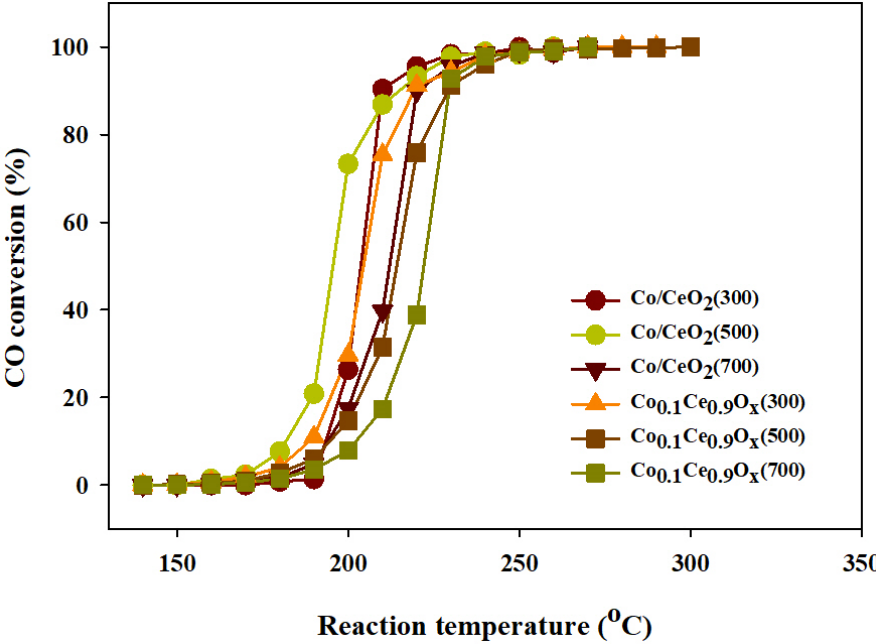
Figure 3. Catalytic activity for CO methanation over ceria-supported cobalt catalysts. All catalysts were reduced in H 2 at 500 °C. The feed gas is composed of 1 mol% CO, 49 mol% He, and 50 mol% were reduced in H 2 at 500 ◦ C. The feed gas is composed of 1 mol% CO, 49 mol% He, and 50 mol% H 2, and the total flow rate is 100 mL/min. H 2, and the total flow rate is 100